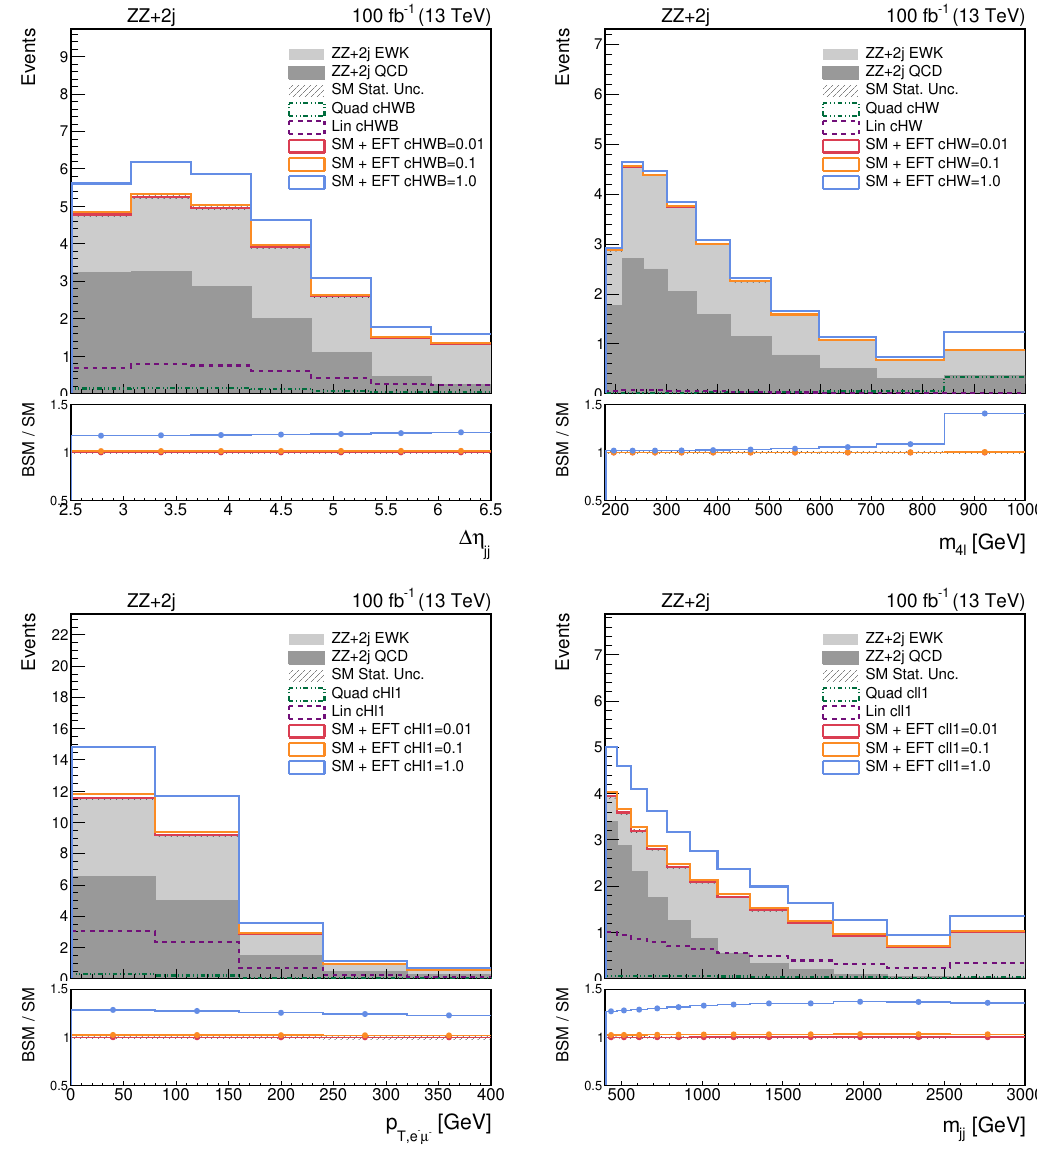
Figure 15 . Comparison of SM (filled histograms) and BSM (lines) expected number of events after the event selection in table 4, for various observables and Wilson coefficients in the ZZ+2j-EW and ZZ+2j-QCD processes, at an integrated luminosity of 100 fb − 1 . The SM distribution is represented as a stacked histogram, summing EW (light grey) and QCD (dark grey) components. Solid lines show the total prediction for one Wilson coefficient at a time, with c 1 TeV − 2 (blue). The pure interference (quadratic) EFT component, normalized to c is indicated with a purple (green) dashed line. For all distributions, the last bin comprises all the overflow